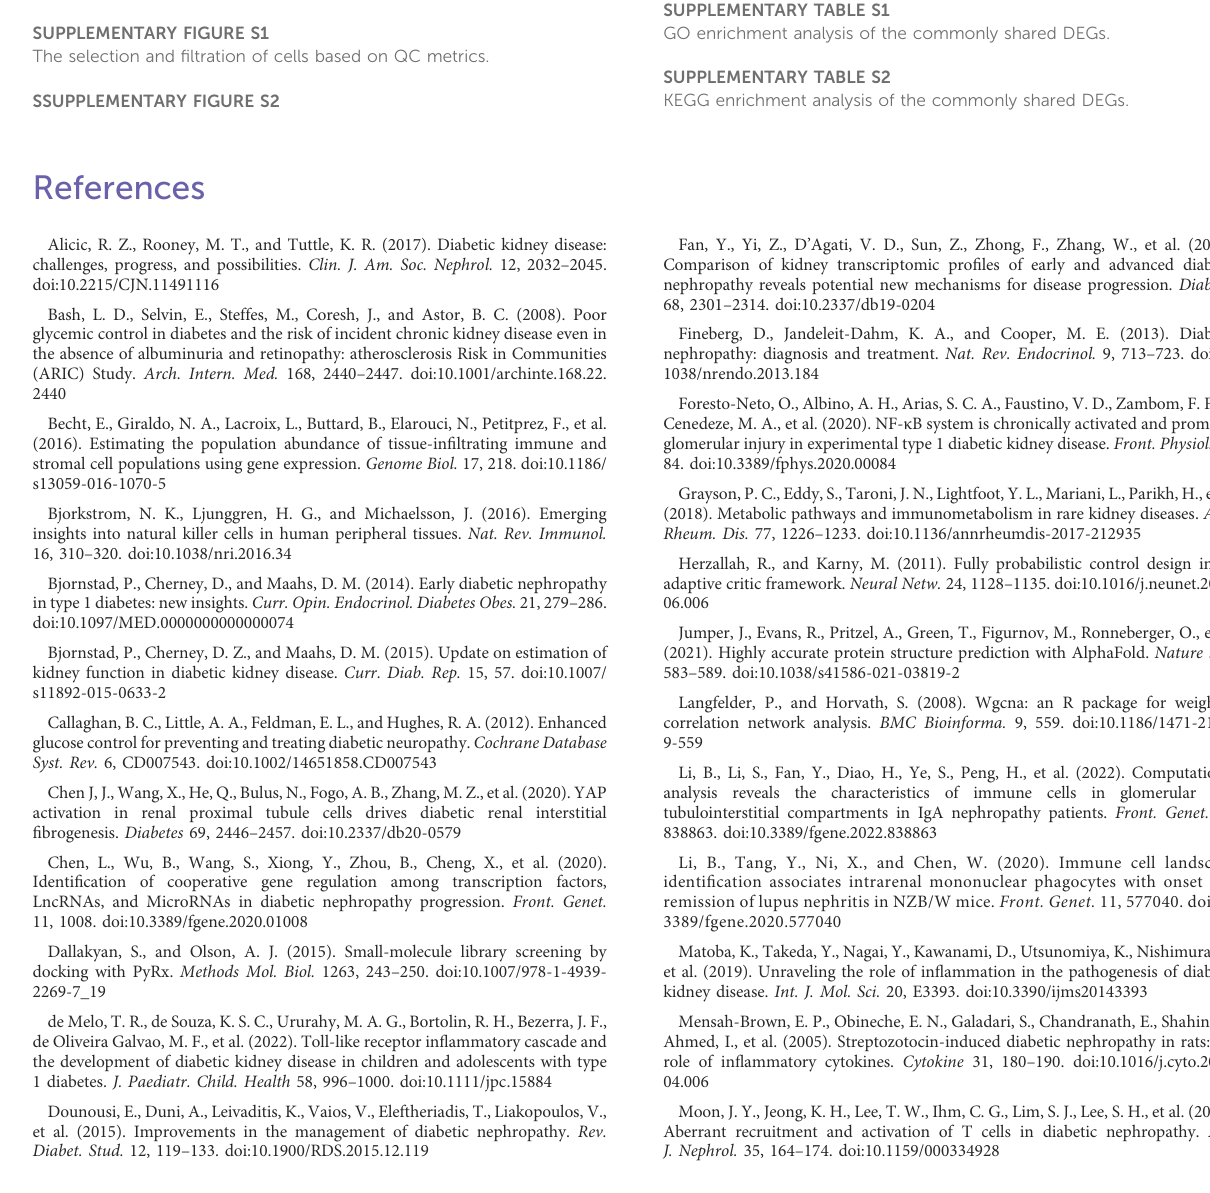
SUPPLEMENTARY FIGURE S1 The selection and fi ltration of cells based on QC metrics.